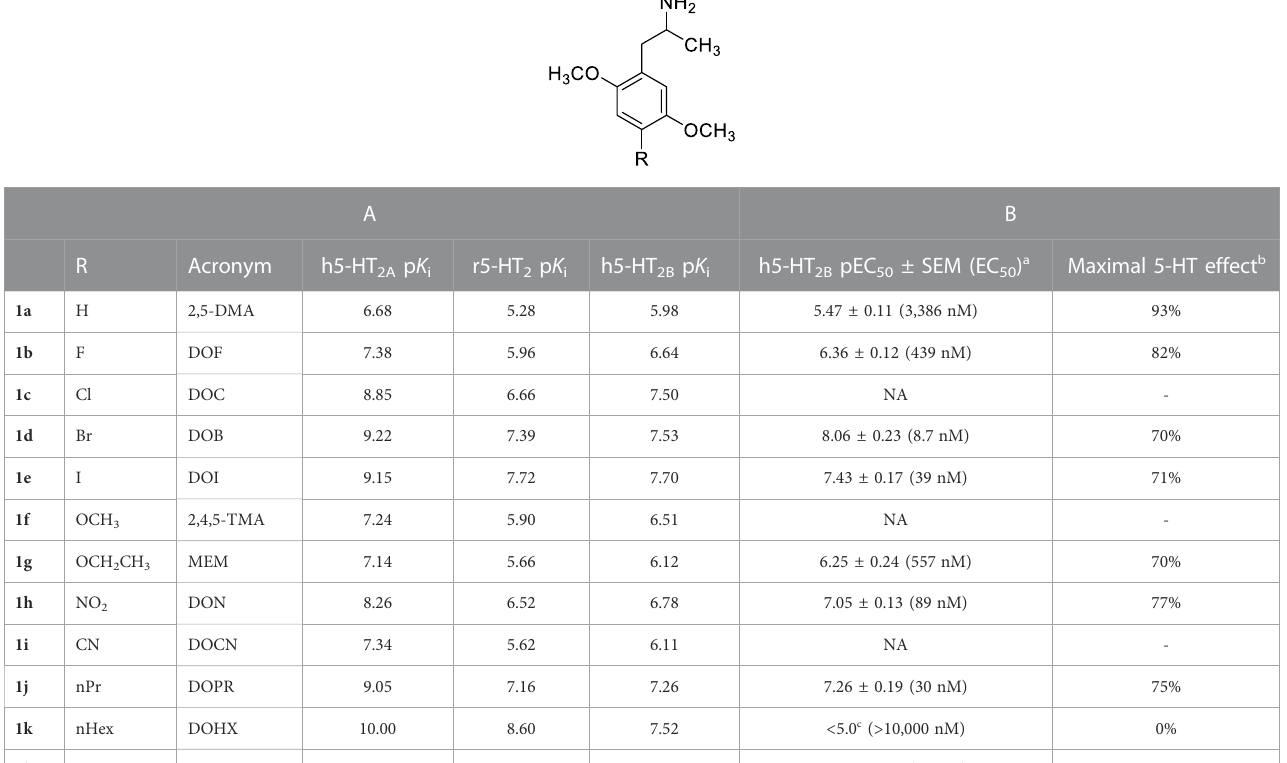
TABLE 1A: Published radioligand binding data(p K i values)foraseries of analogues 1 commonto human5-HT 2A vs.[ 125 I]DOI, human5-HT 2B vs.[ 3 H]5-HT (Nelson etal.,1999) and rat 5-HT 2 vs. [ 3 H]ketanserin (Seggel et al., 1990) receptor studies, and B: agonist potencies (EC 50 values) and maximal 5-HT-related effect (5-HT = 100%) at human 5-HT 2B (h5- HT 2B ) receptors as determined in this